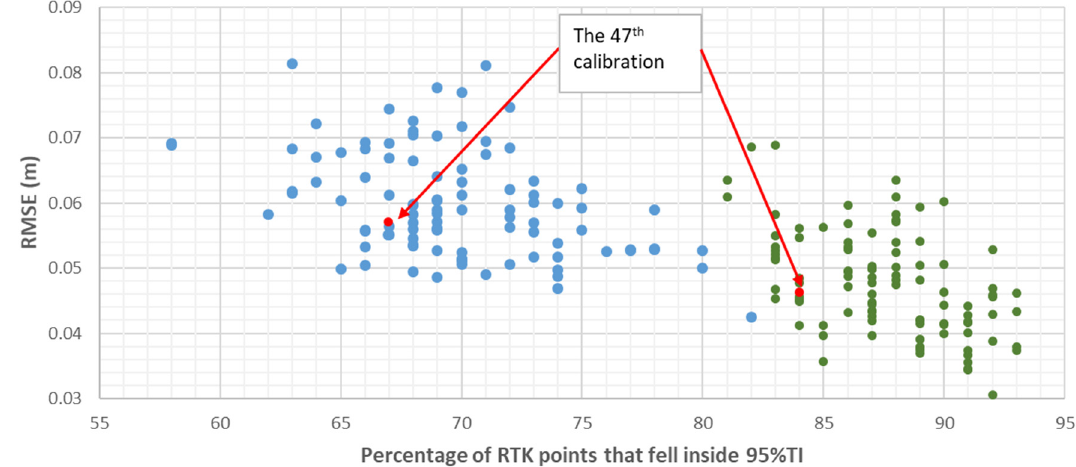
Figure 6. Statistical evaluation of 6 ( blue ) and 12 ( green ) input ensemble neural networks (ENNs) based on root mean square error (RMSE) and percentage of RTK points that fell inside the ENN tolerance interval (TI) for 100 independent runs. Calibration case 47th ( red ) is the most representative when considering both six-input and 12-input ENNs.